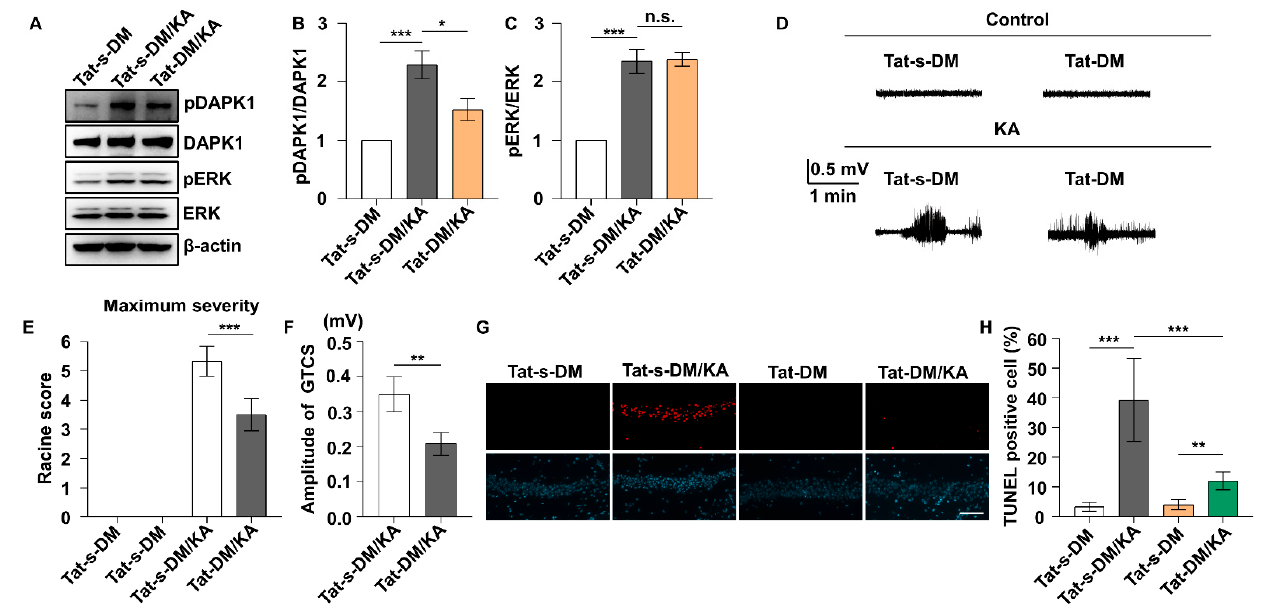
Figure 3. Tat-DM rescues seizure severity and reduces neuronal apoptosis induced by KA. Electrodes were implanted into mice (C57BL/6, male/female, 8–12 weeks, n = 10/group), which were allowed to recover for 7 days. The mice were treated with Tat-DM (10 mg/kg, i.p.) or Tat-s-DM for 3 h before KA administration. Hippocampal tissues were dissected from a number of the animals ( n = 4 per group) 30 min after KA insult for use in immunoblotting assays, and EEG traces and behavioral analysis were continuously performed in the remaining mice for 120 min. ( A – C ) Tat-DM intervention suppresses DAPK1 activity after KA treatment. The brain lysates were resolved on SDS-PAGE gels and then subjected to immunoblotting using anti-pSer735-DAPK1, anti-DAPK1, anti-pThr202/Tyr204 ERK, anti-ERK, or anti- β -actin antibodies (* p < 0.05, *** p < 0.001, one-way ANOVA with Tukey’s multiple comparisons test). ( D ) Representative EEG recordings from 0.9% saline- and KA-treated mice are shown for the Tat-s-DM and Tat-DM groups. ( E , F ) Tat-DM-treated mice exhibited reduced seizure scales ( E ) and reduced GTCS amplitudes (F) post KA administration (** p < 0.01, *** p < 0.001, Student’s t -test). ( G ) Representative images showing TUNEL and Hoechst 33,342 staining in the analysis of the TUNEL assay results (** p < 0.01, *** p < 0.001, one-way ANOVA with Tukey’s multiple comparisons test). Scale bar, 100 µ m. n.s., not significant ( p > 0.05). All the values were combined and are expressed as the mean ± SD. Experiments were performed in triplicate with at least three mice per group per